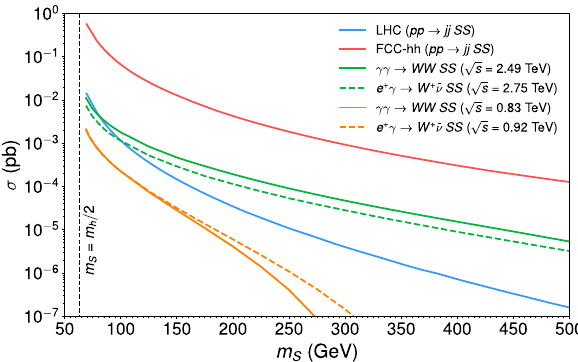
Fig. 4 LO cross section for singlet pair production (for λ HS = 1) as a function of m S via γγ → W + W − SS (solid) and e + γ → W + ¯ ν SS (dashed) for a 3 TeV CLIC-based collider (green) and a 1 TeV ILC- based collider (orange). The E max γ / E e = 0 . 83 factor is explicitly taken into account. Also shown are the LO cross sections for 14 TeV LHC (blue) and 100 TeV FCC-hh (red) via the process pp →